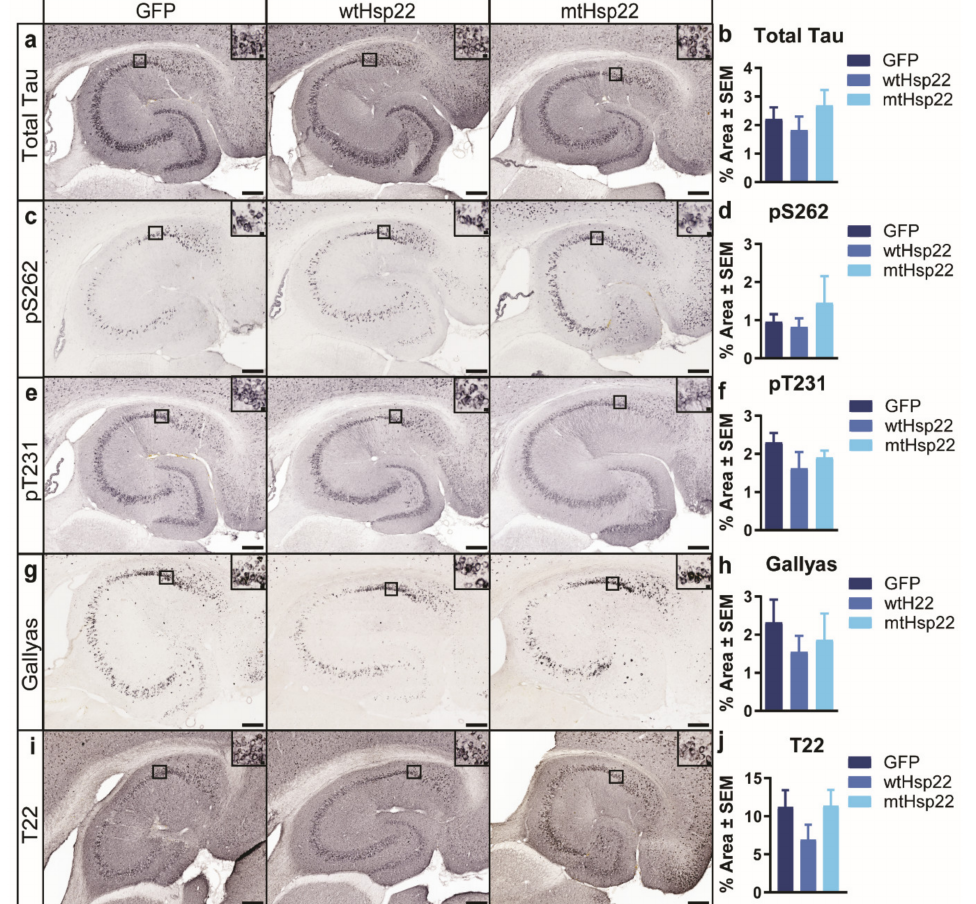
Figure 4. Overexpression of wtHsp22 and mtHsp22 does not alter tau accumulation. Immunohisto- chemical staining and quantification of the hippocampi of rTg4510 mice injected with GFP ( n = 6), wtHsp22 ( n = 6), or mtHsp22 ( n = 6) for ( a , b ) total tau; ( c , d ) pS262 tau; ( e , f ) pT231 tau; ( g , h ) Gallyas silver, and ( i , j ) T22 oligomeric tau (mean ± SEM; scale bar represents 200 µ m; inset represents 10 µ m).